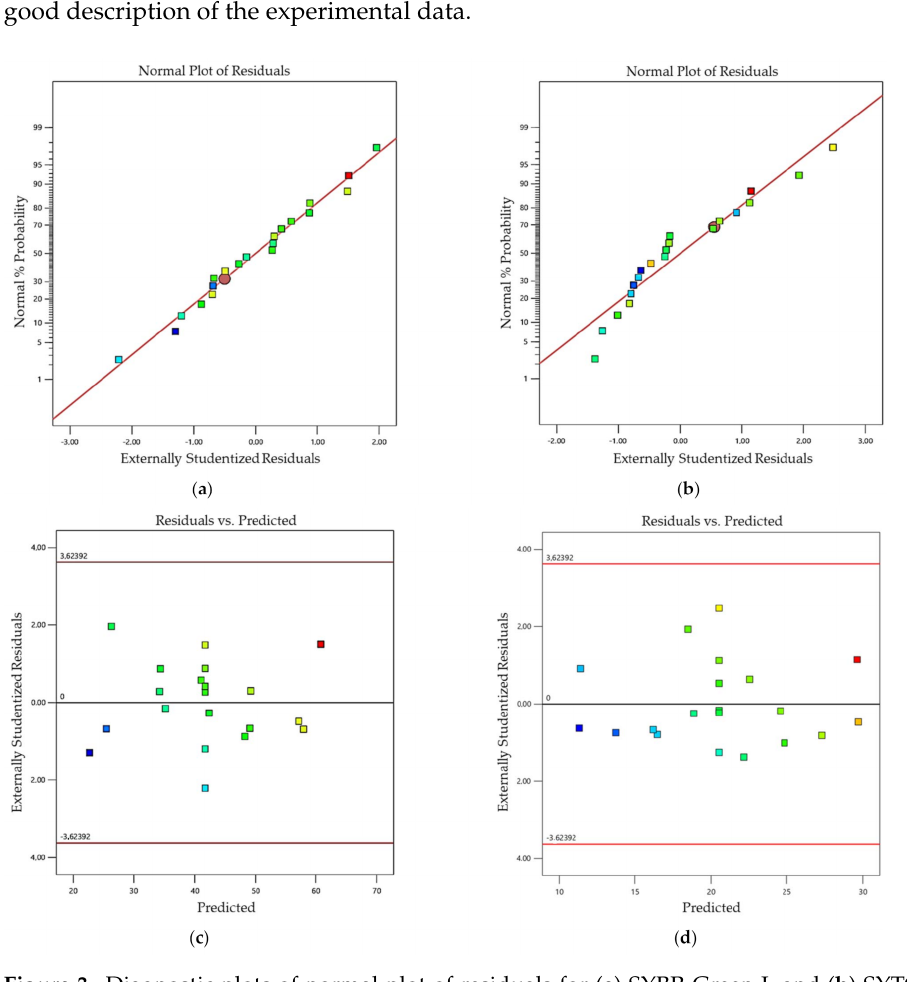
Figure 3. Diagnostic plots of normal plot of residuals for ( a ) SYBR Green I, and ( b ) SYTO9; and residuals vs. predicted for ( c ) SYBR Green I, and ( d )